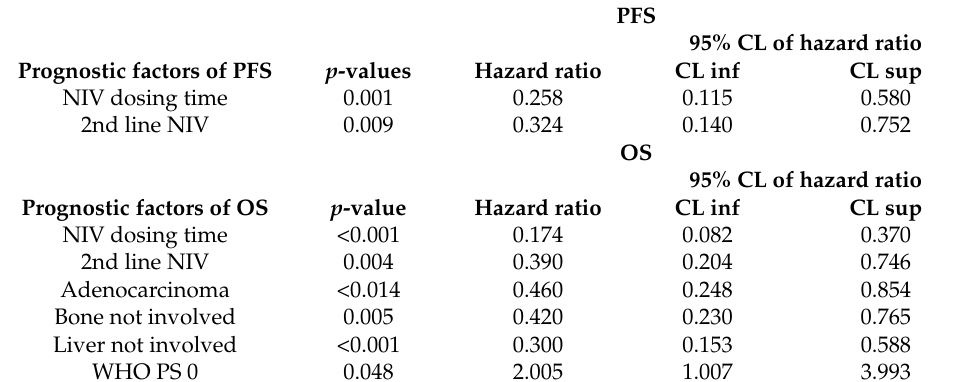
Figure 5. Forest plots of progression-free survival (PFS, ( a )) and overall survival (OS, ( b )), according to categorized patient characteristics. Hazard ratios and 95% CL of an earlier progression or an earlier death for ‘morning’ vs. ‘afternoon’ nivolumab groups. Table 3. Prognostic factors of PFS and